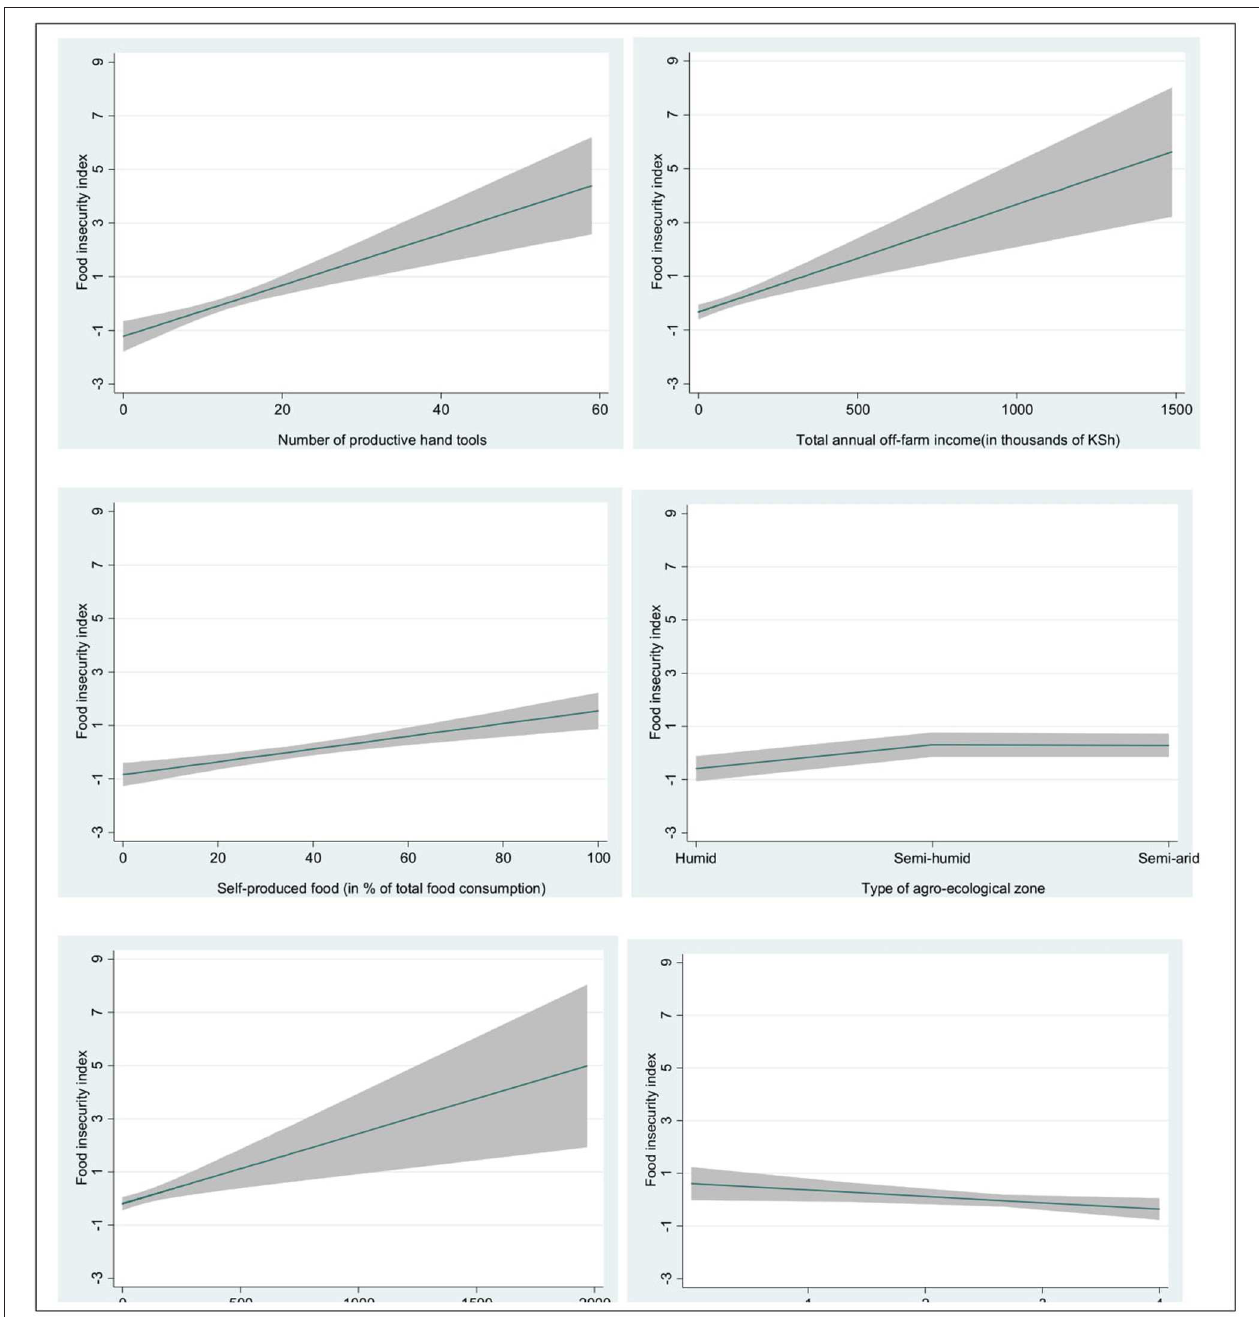
FIGURE 2 | Marginal plots showing the relationship between the significant variables and the household composite food security index. The gray shaded area on each plot represent the confidence